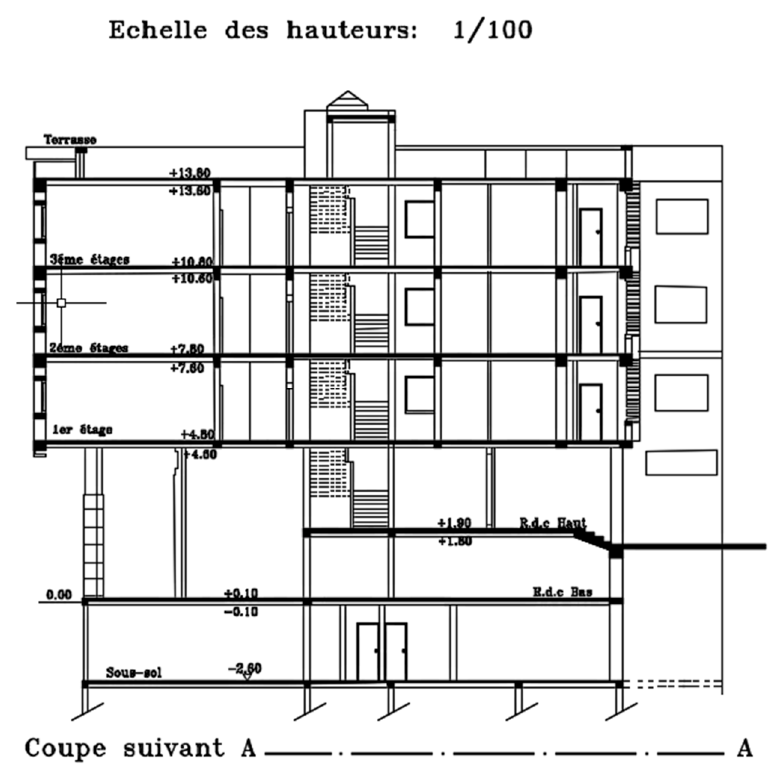
Figure 11. A vertical graphic of the building.